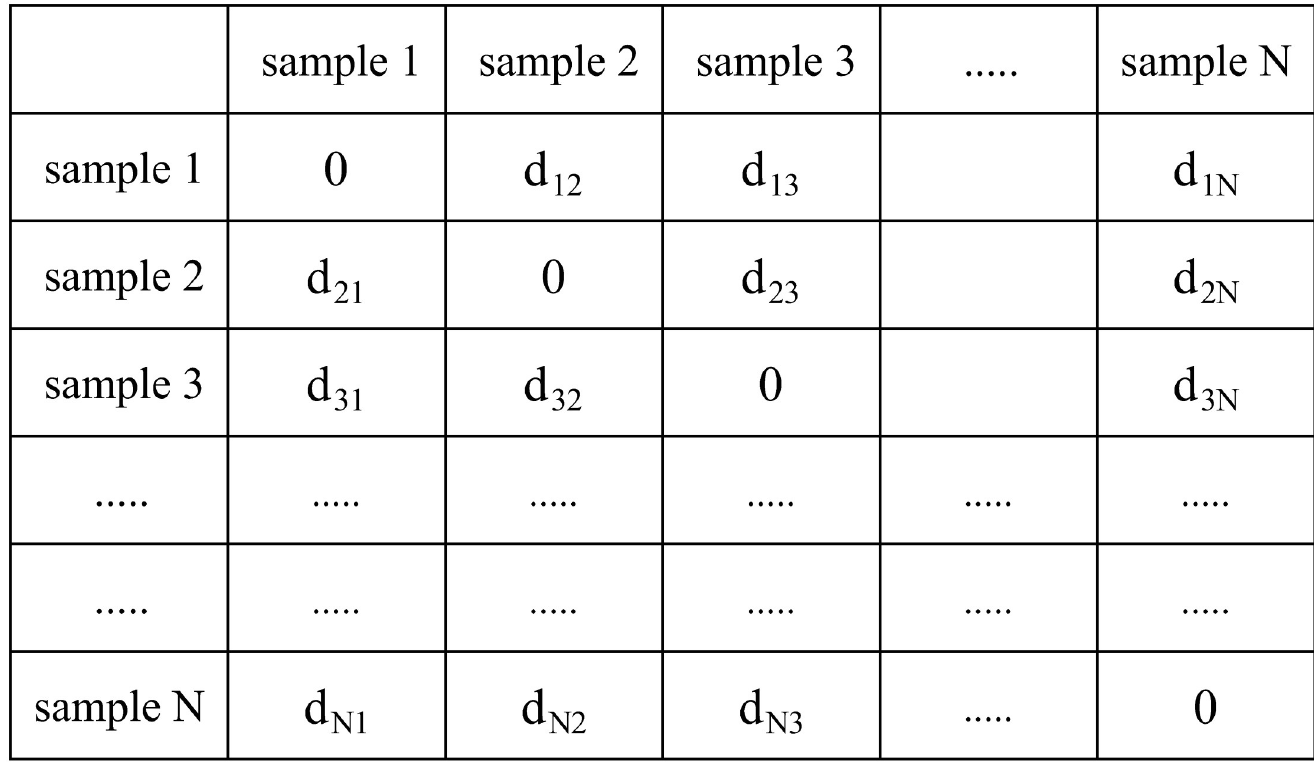
Fig 5. Matrix of Hamming distances. Matrix of Hamming distances d